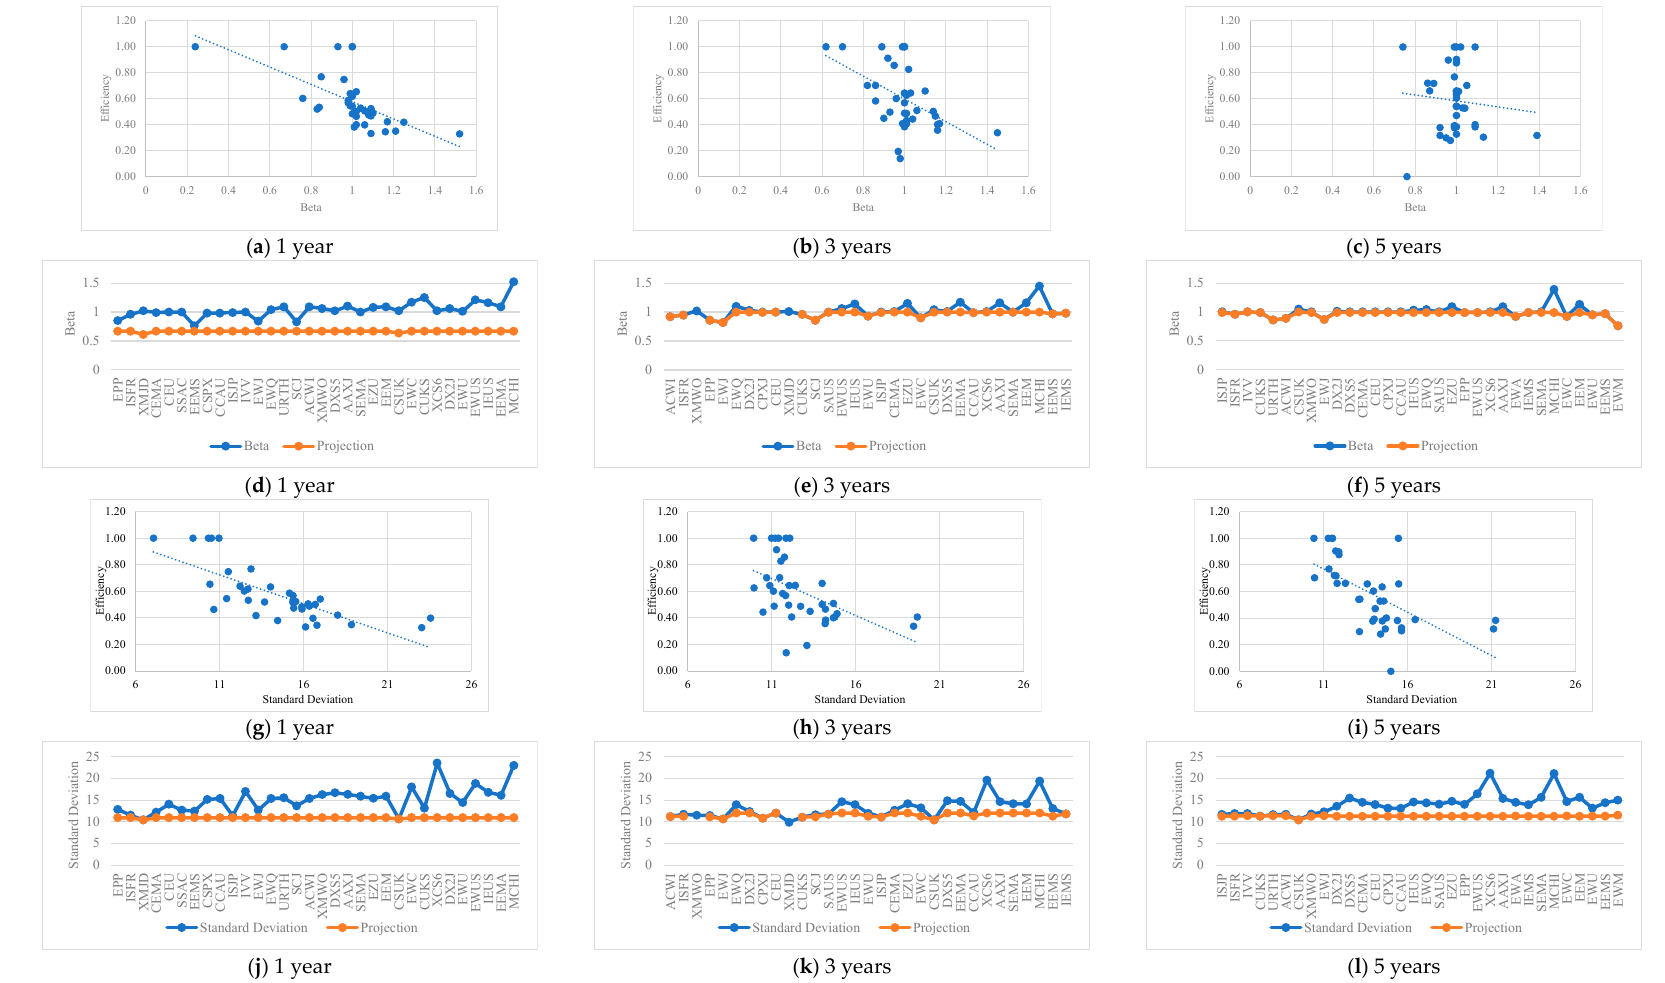
Figure 5. Efficiency scores vs. inputs and projections (ETFs are ordered in decreasing order of efficiency) for the different time horizons–M3.